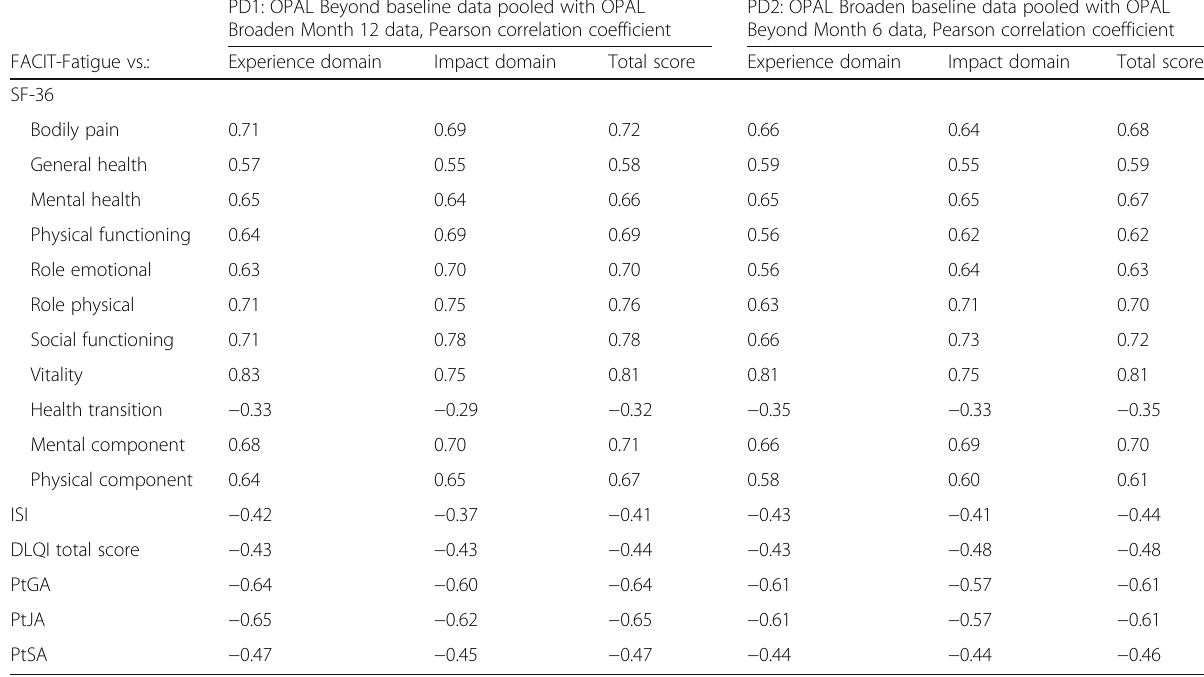
PD2: OPAL Broaden baseline data pooled with OPAL Beyond Month 6 data, Pearson correlation coefficient